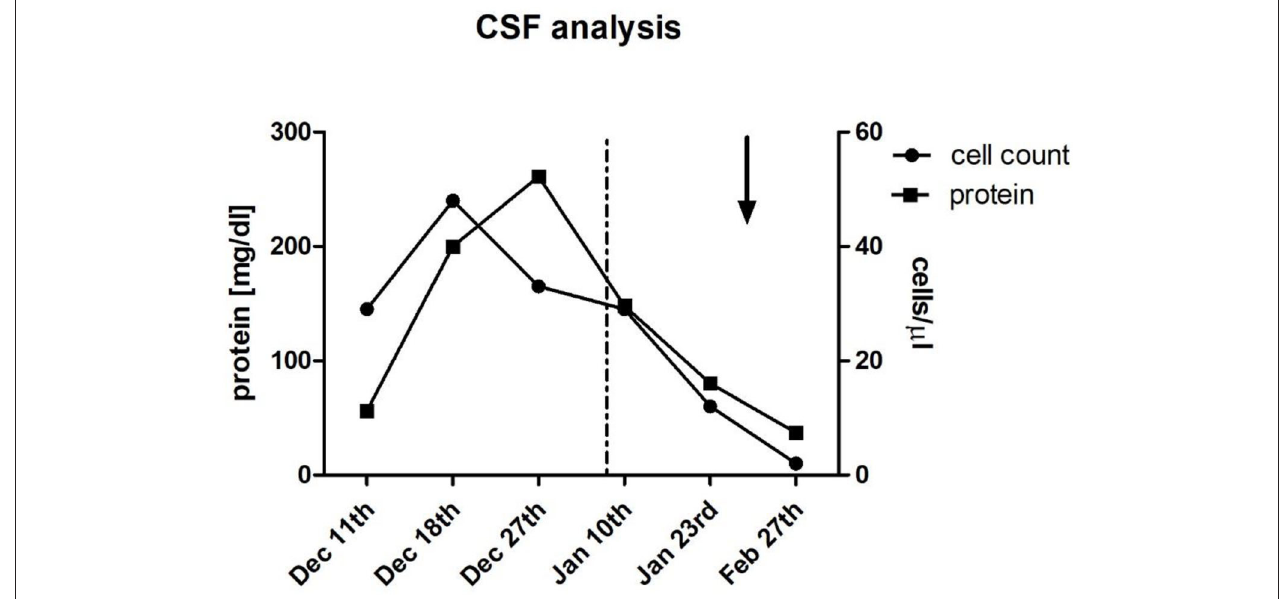
FIGURE 1 | Cerebrospinal fluid (CSF) analysis. Multiple lumbar punctures during hospitalization and outpatient follow-up showed initial lymphocytic pleocytosis (up to 48 cells/ µ l) and elevated protein (up to 261 mg/dl) which improved after discontinuation of dupilumab (dotted line; Jan 8th), followed by administration of 1g Methylprednisolone IV for 3 days (arrow; Jan 27th), and subsequent oral steroid treatment for 4 weeks.